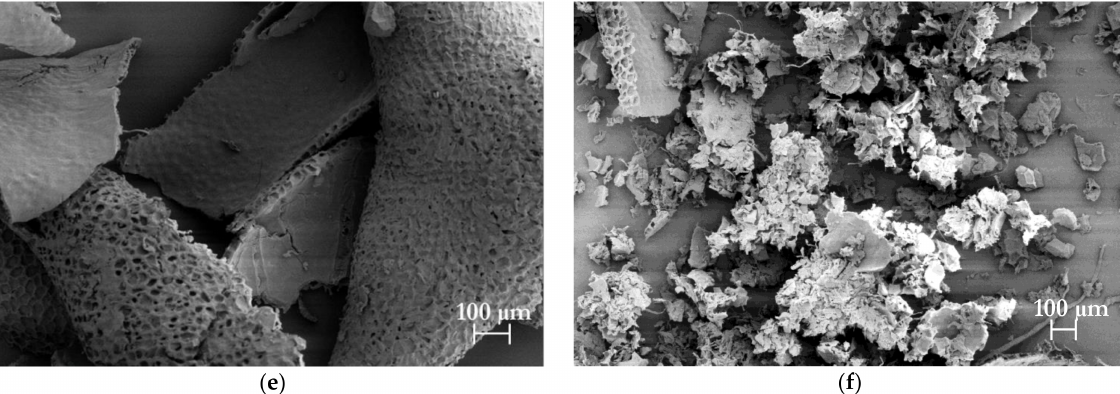
Figure 6. Optical microscopy ( a , b ) at 10 × magnification and SEM ( c – f ) images at different magnifi- cations (500 × magnification for ( c , d ), 150 × magnification for ( e , f ) of cellulose isolated from tomato pomace (TP) (left column, ( a , c , e )) and high-pressure homogenized tomato pomace (HPH-TP) (right column, ( b , d , f )) through the mild chemical hydrolysis cascade process.